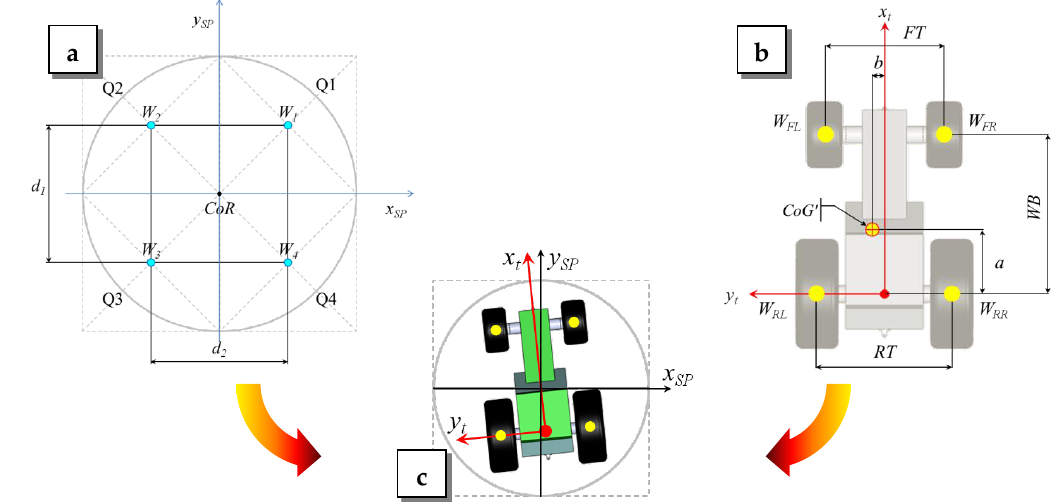
Figure 8. ( a ) Main dimensions characterizing the positions of the load cells on the support plane; ( b ) dimensions characterizing a vehicle (here: a conventional farm tractor) and position of the CoG projection on the support plane (i.e., of CoG (cid:48) ); ( c ) real test